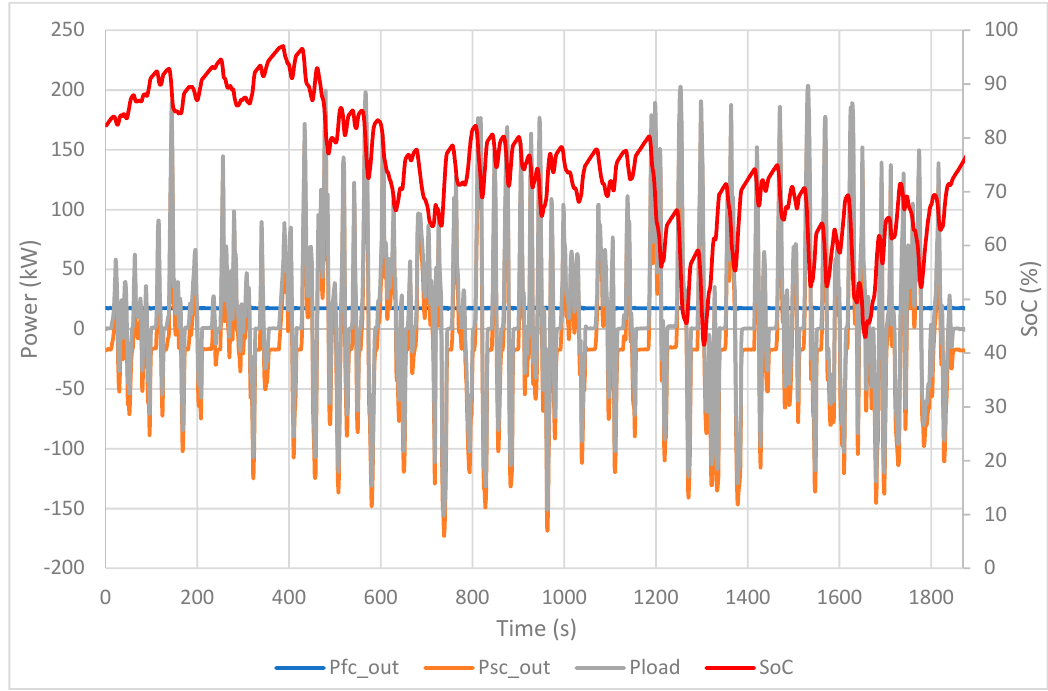
Figure 9. Power balancing and SoC change of the bus journey with the highest average power.